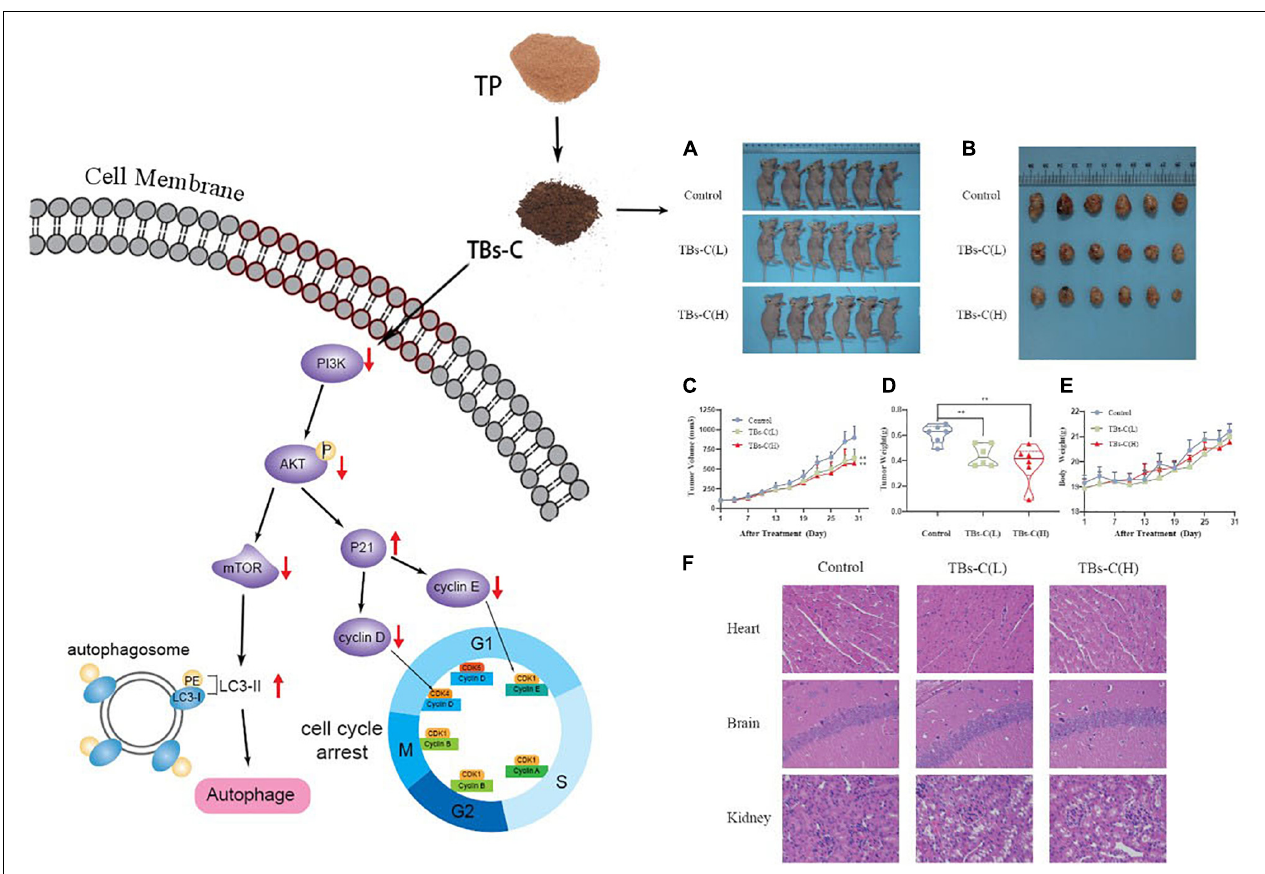
FIGURE 10 | Schematic diagram of TBs-C inhibiting human NSCLC cells in vitro and in vivo . In vitro , TBs-C is capable of increasing autophagic flux, inhibiting cell proliferation, enhancing apoptosis, and inducing G1 cell cycle arrest via the PI3K/AKT/mTOR pathway and AKT/p21 axis. In vivo , TBs-C enhances autophagy and inhibits tumor growth by downregulating the PI3K/AKT/mTOR pathway without causing cardiac, brain, or kidney